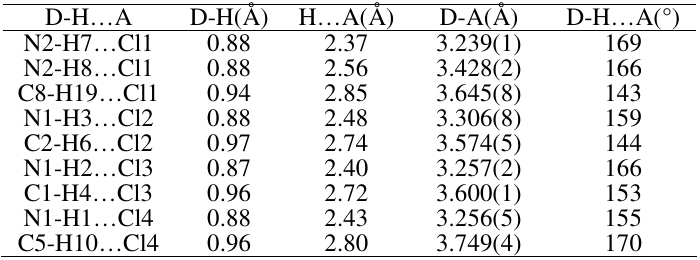
H N ]ZnCl 9 22 2 4